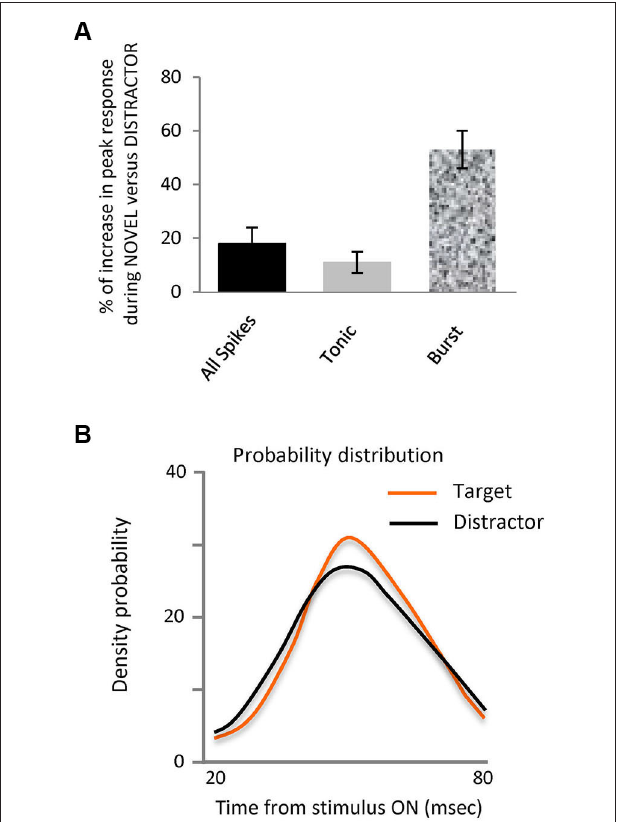
FIGURE 2 | Novel stimuli evoke more spikes in bursts and are differently organized. (A) Bar histogram representing the increase in peak response to the target stimulus vs. distractors for all spikes, tonic and burst. (B) Probability density distribution of spikes in bursts during interval from 20 to 80 ms after stimulus onset for each stimulus, target and distractors. This shows that the distribution of the spikes in bursts within the 20 to 80 ms interval evoked by target falling on the RF was significantly different to those evoked by the distractors, (Kolmogorov-Smirnov Test, p <